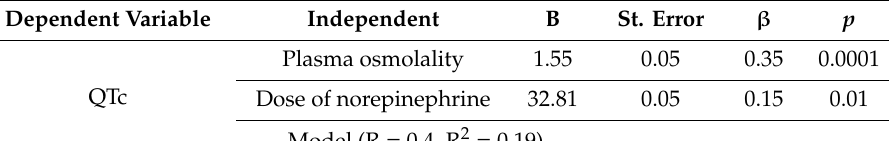
Table 2. Factors influencing QTc interval estimated by multivariate stepwise regression analysis.